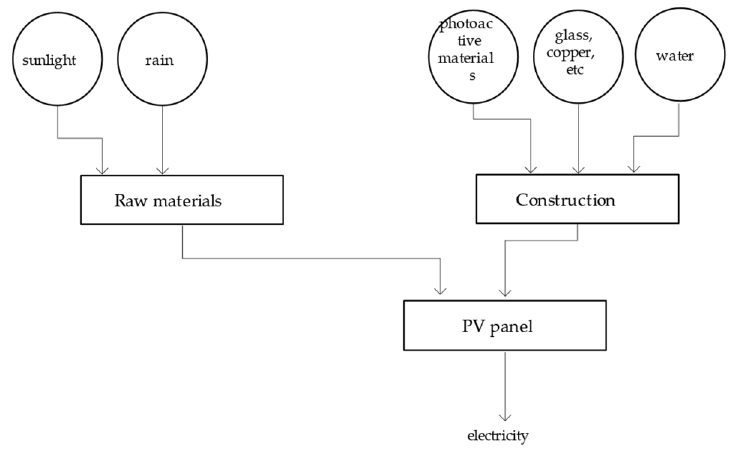
Figure 8. System diagram of the solar power